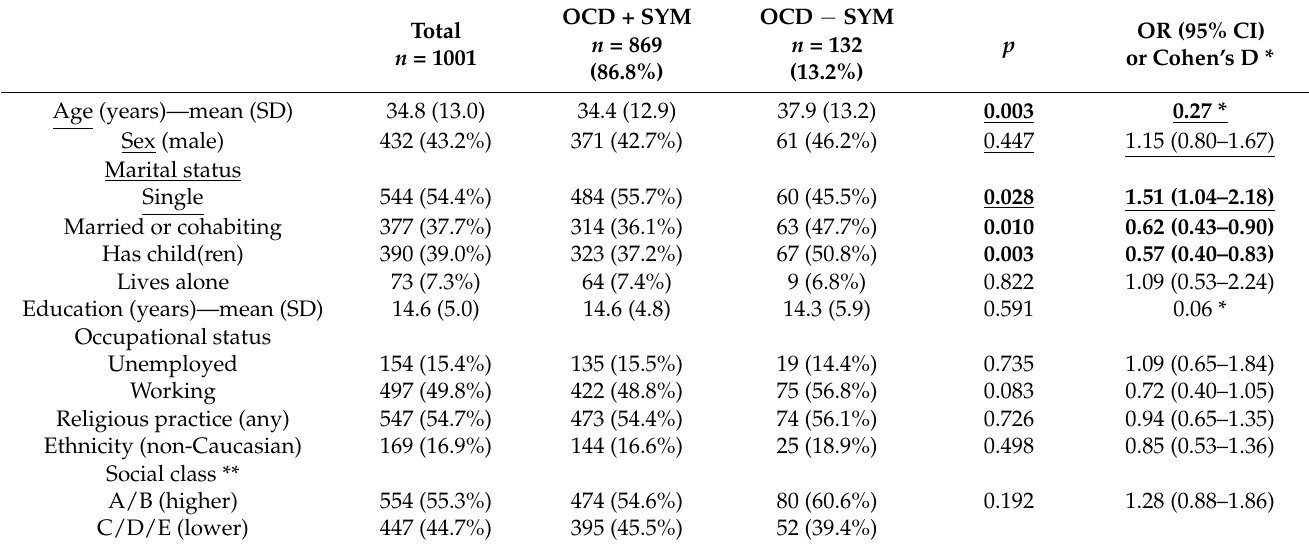
Table 1. Demographic characteristics of 1001 OCD patients with (OCD + SYM) and without (OCD − SYM) symptoms of the symmetry